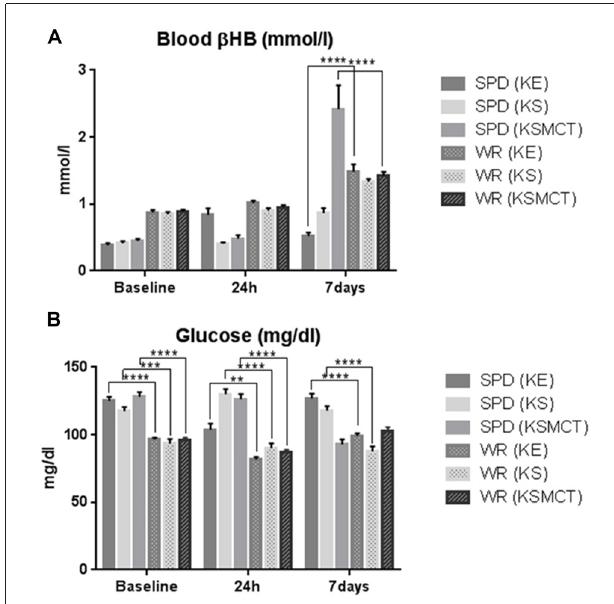
FIGURE 4 | Blood β HB and glucose levels compared between the two animal models. (A) Blood β HB levels were higher at 7 days in WAG/Rij rats after KE and KSMCT treatment. (B) Blood glucose levels were significantly lower in WAG/Rij rats, except in KSMCT group at 7 days. ( ∗∗ p < 0.01; ∗∗∗ p < 0.001; ∗∗∗∗ p <